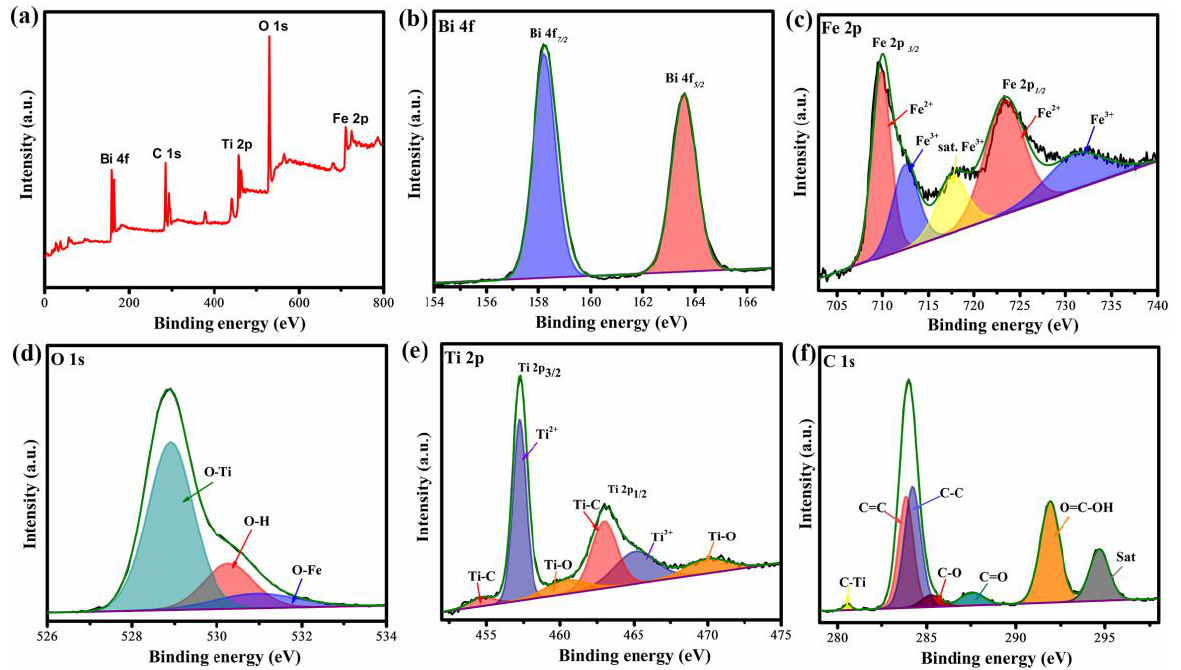
Figure 3. XPS analysis ( a ) survey scan of BiFeO 3 /MXene and high-resolution scans of ( b ) Bi 4f, ( c ) Fe 2p, ( d ) O 1s, ( e ) Ti 2p, and ( f ) C 1s.